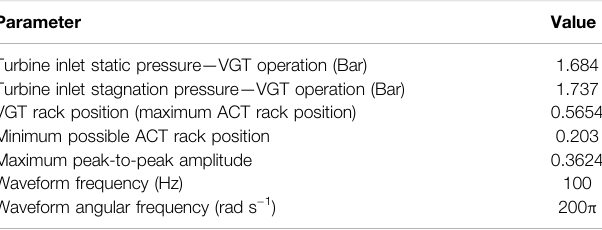
TABLE 5 | Calculated values of ACT parameters for the 8 Bar BMEP at 3,000 rev min − 1 cruise condition.